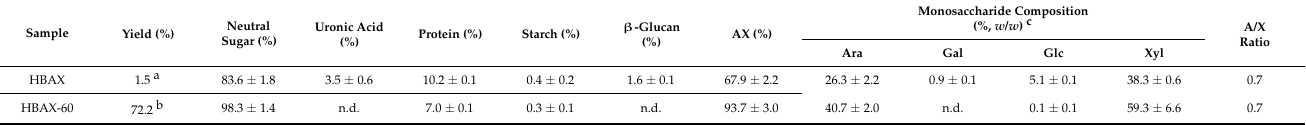
Table 1. Chemical properties and monosaccharide compositions of arabinoxylan from hull-less